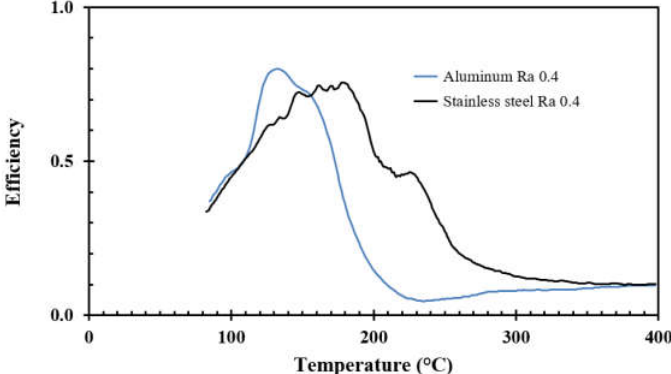
Figure 16. Average cooling efficiency for water droplets impinging onto the stainless steel and aluminum disc (marked on the figure) with a surface roughness of Ra 0.4.